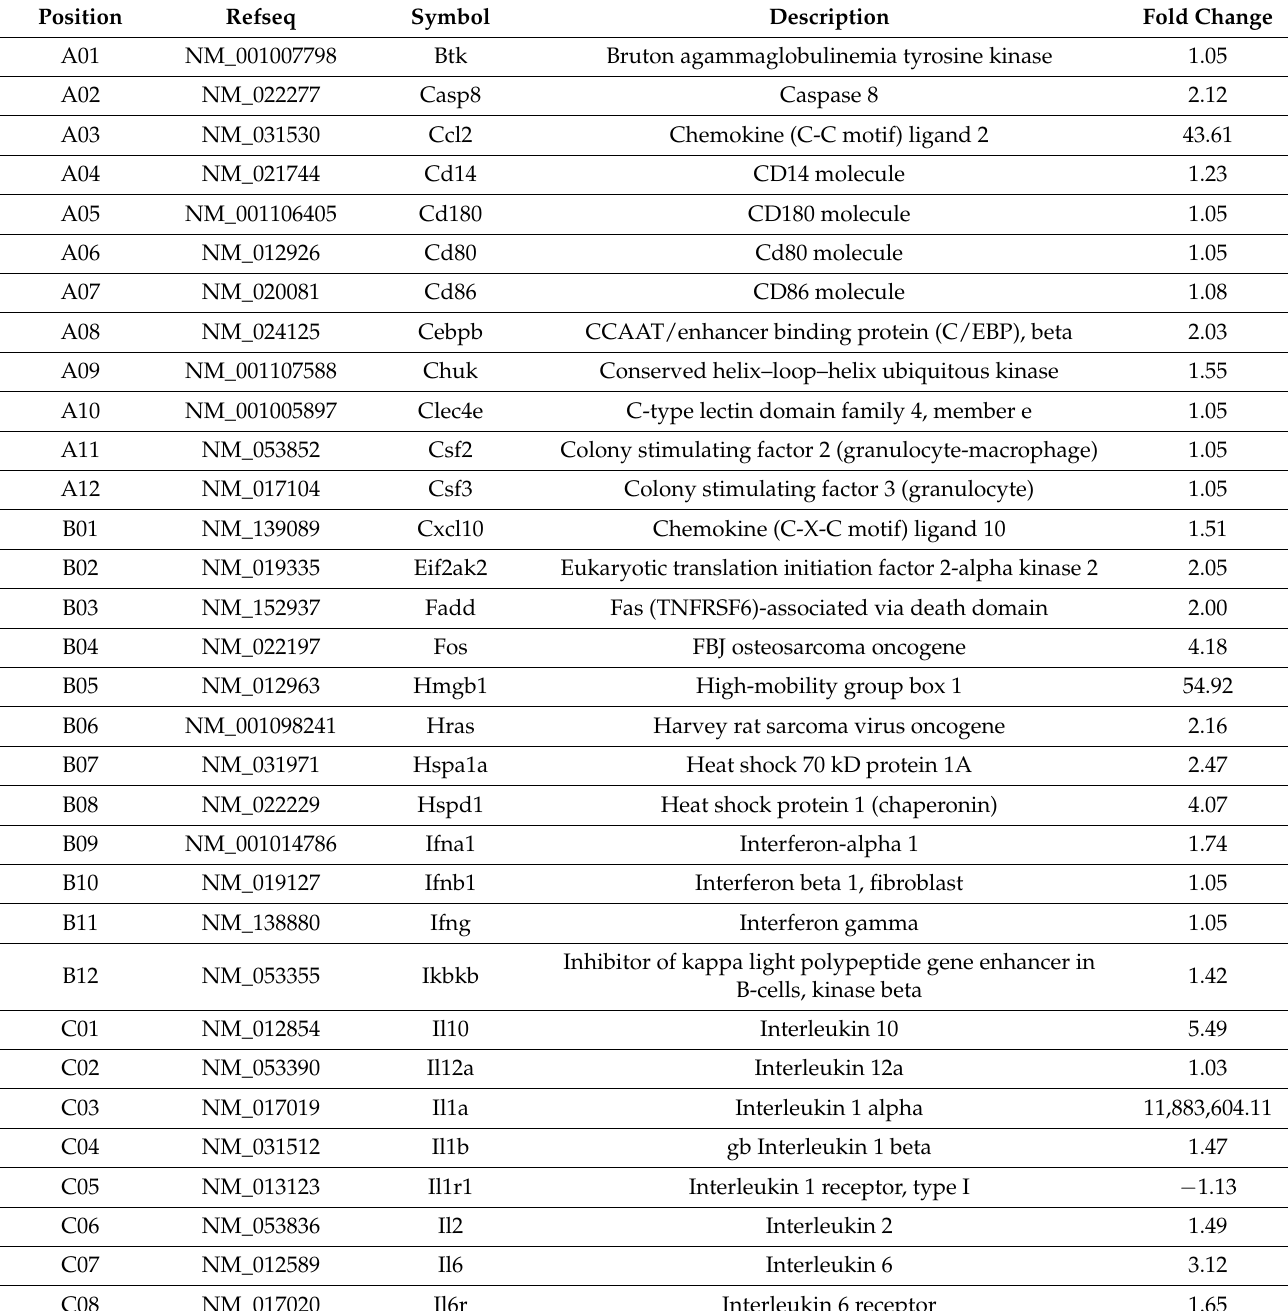
Table 2. Rat TLR RT2 Profiler PCR Array (Qiagen). NCBI access number, abbreviation (symbol) and full name/function (description) of the 84 TLR-related genes analyzed using the PCR array. The column “fold change” indicates the tested gene expression in burn injury group vs. sham